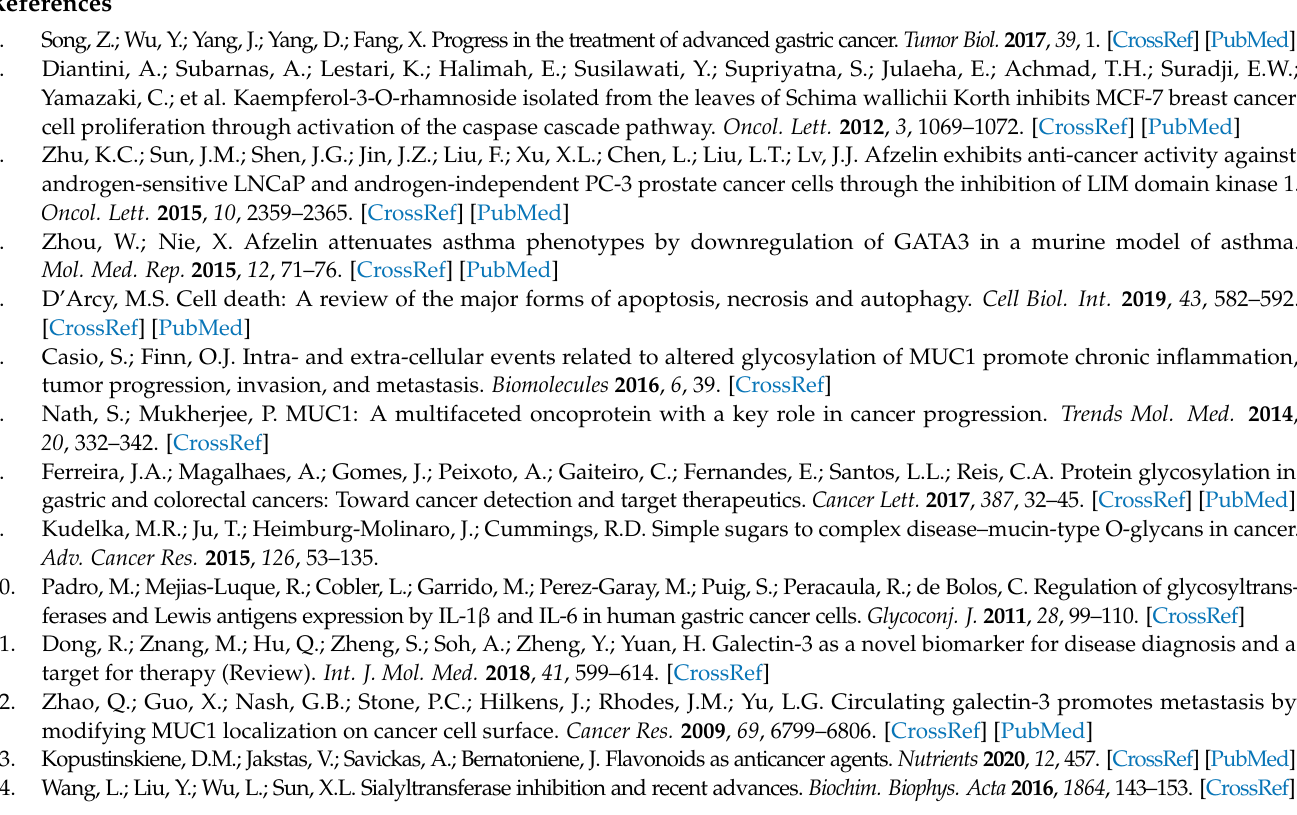
Figure 8A; Figure S4: Original images of Western blots to Figure 9A–D; Figure S5: Original images of Western blots to Figure